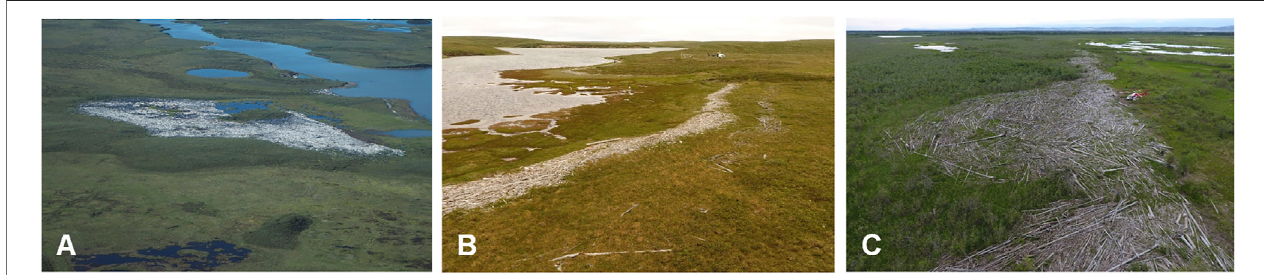
FIGURE 2 | Examples of large driftwood accumulations along the southern Beaufort coast: large pile (9 ha) at Canyanek Inlet (A) , Two distinct driftwood lines with thehighestelevationconsistingofolderwoodydebrispartiallyburiedwithinthesoilandvegetationatMasonBay (B) andaninlandsiteintheMackenzieDeltawithwood transported over 9 km from the coast (C)